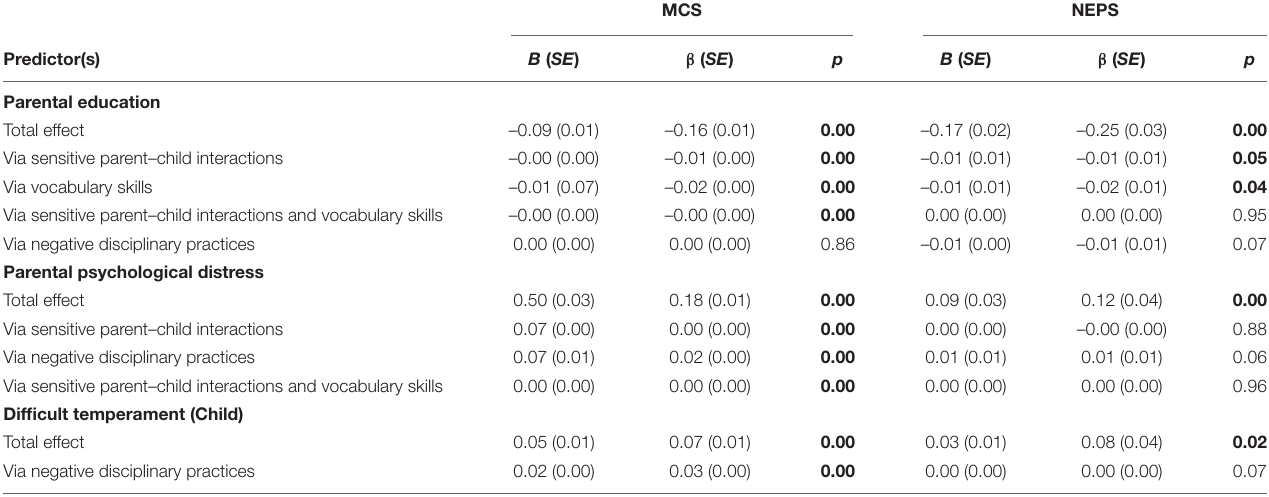
TABLE 4 | Total and indirect effects to children’s behavioral